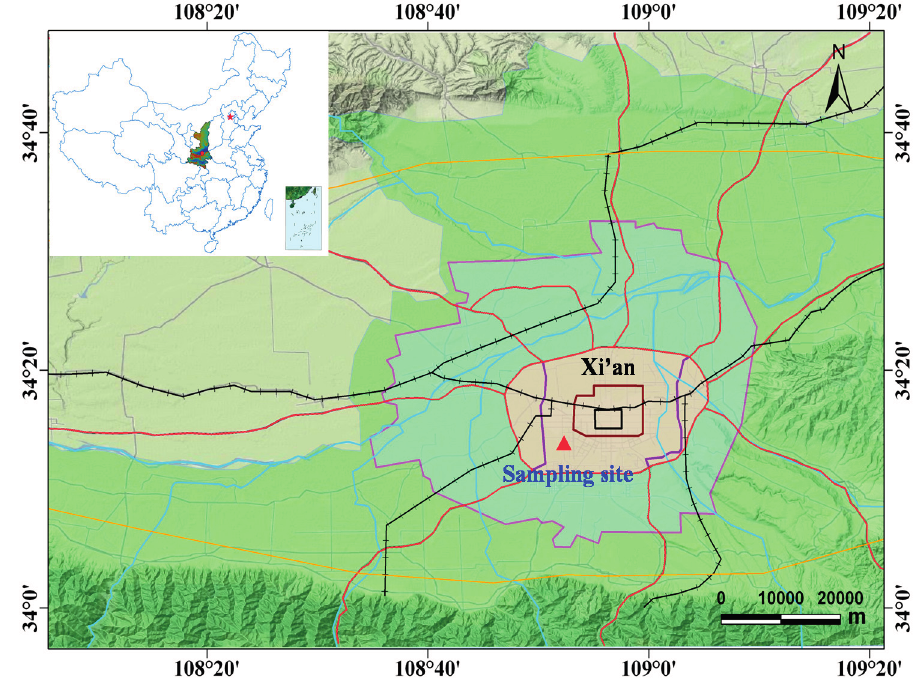
Figure 1. Location of the Xi’an sampling